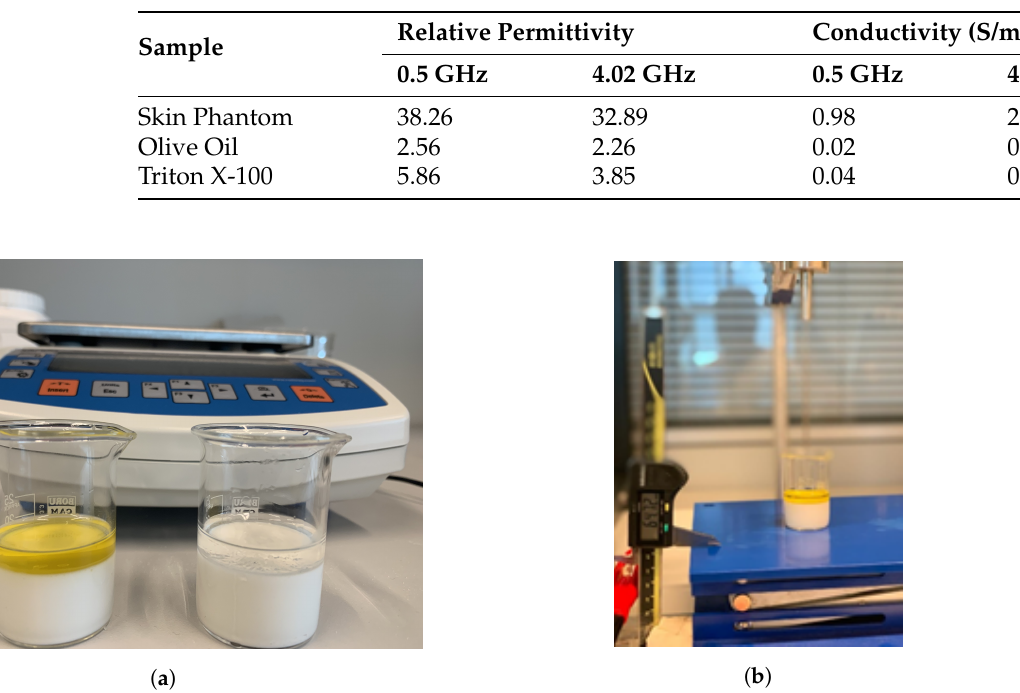
Figure 3. Double-layered configurations and part of the experiment setup for the measurement of layer thickness and step size: ( a ) skin phantom-olive oil (left) and skin phantom-triton X-100 (right), ( b ) adjustable stand and digital caliper for thickness